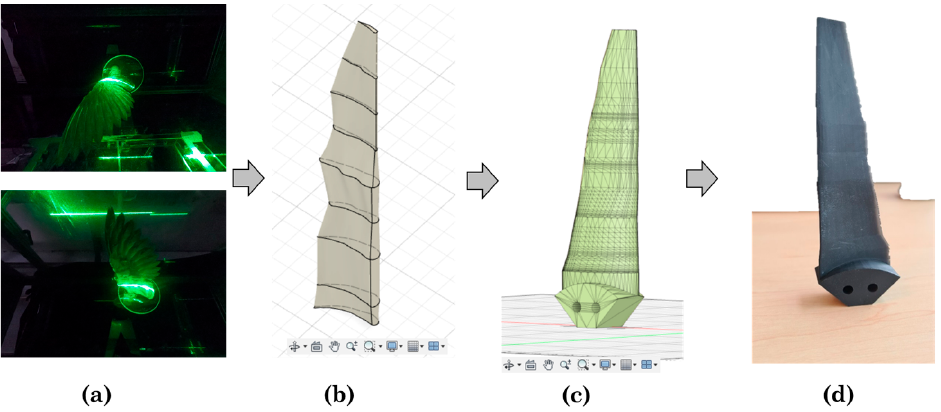
Figure 13. Bio-inspired blade processes: ( a ) Laser scanning method, ( b ) Scanned profiles from the bird wing imported and positioned in Autodesk Fusion 360 ©, ( c ) Line up and adjust of selected known database profiles, ( d ) Scaled 3D printed model.